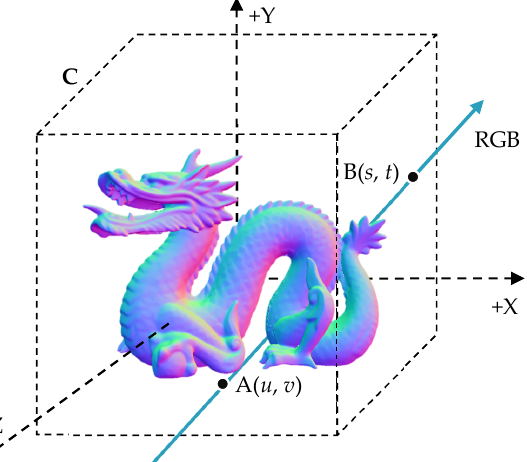
Figure 2. The cube surface light field representation. The parameters of each light ray are defined by the two intersections (A and B) with the cube surface and the ray’s colors are defined by the RGB color at the first intersection with the object’s